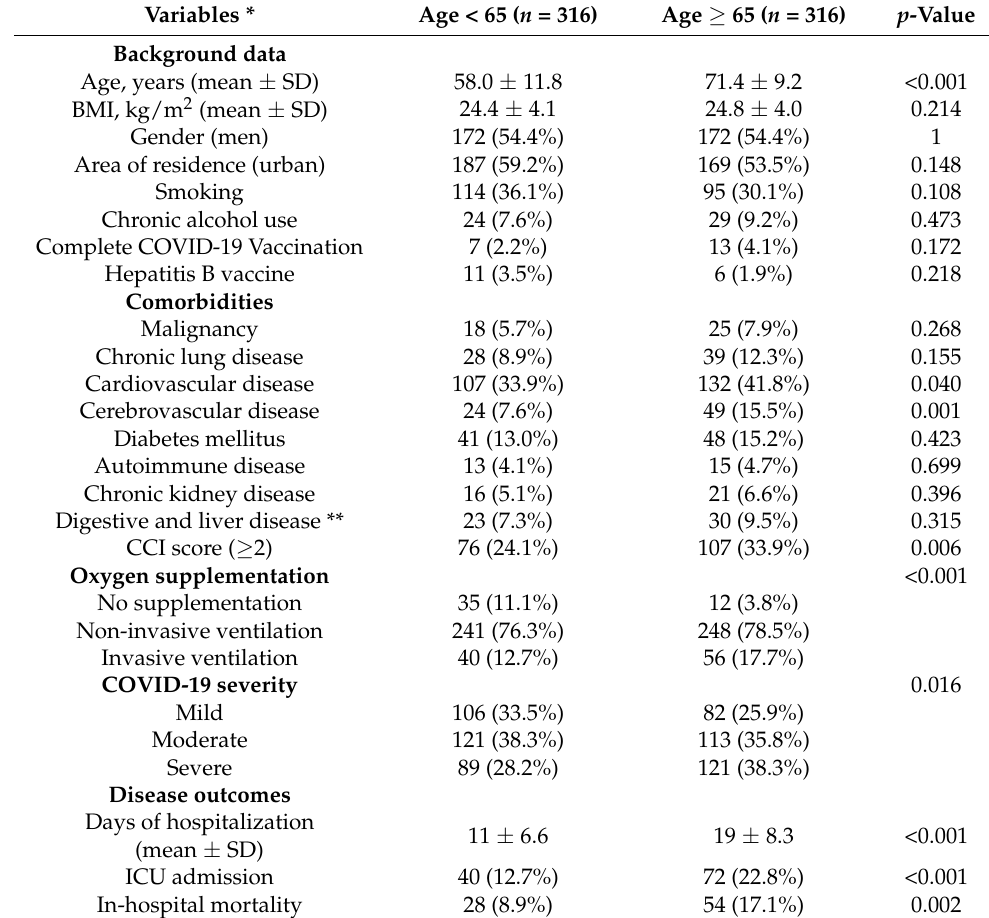
Table 1. Comparison of baseline characteristics between cases and